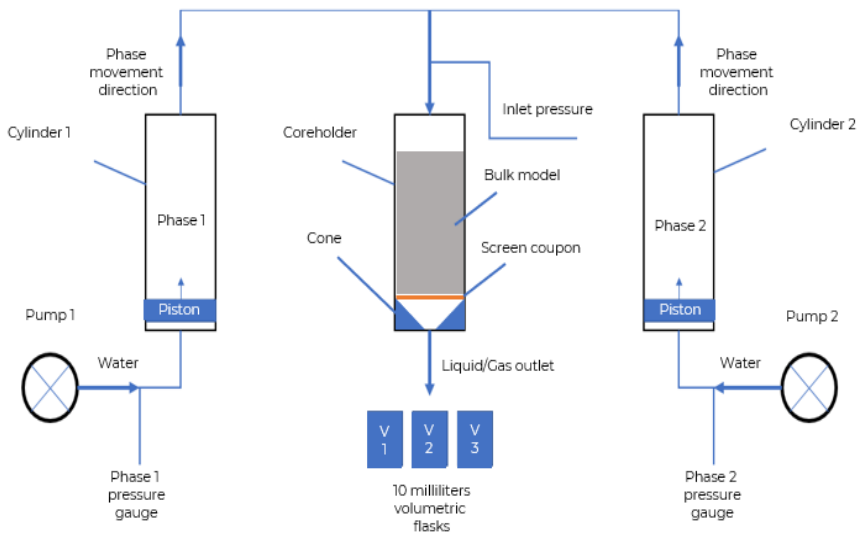
Figure 4. General scheme of the facility [20].